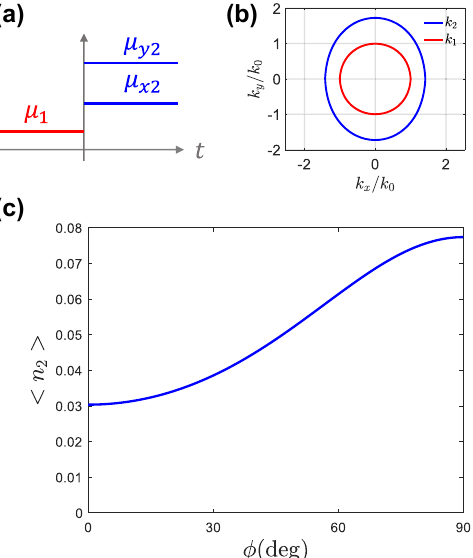
Figure 4: Anisotropic temporal boundaries from isotropic to uniaxial media. (a) Sketch of an anisotropic temporal boundary, where an = 𝜇 ( ̂ x ̂ x + ̂ y ̂ y ), is suddenly transformed into isotropic medium, 𝝁 1 1 ̂ x ̂ x + 𝜇 ̂ y ̂ y . The pemittivity is = 𝜇 an anisotropic medium, 𝝁 2 x 2 y 2 = 𝜀 = 1. (b) Isofrequency assumed to be unity in both cases, 𝜀 1 z 2 z = 1, 𝜇 = 2 contours before and after the temporal boundary, for 𝜇 1 2 x = 3. (c) Photon production for modes with a common and 𝜇 2 y wavenumber k as a function of the angle of propagation 𝜙